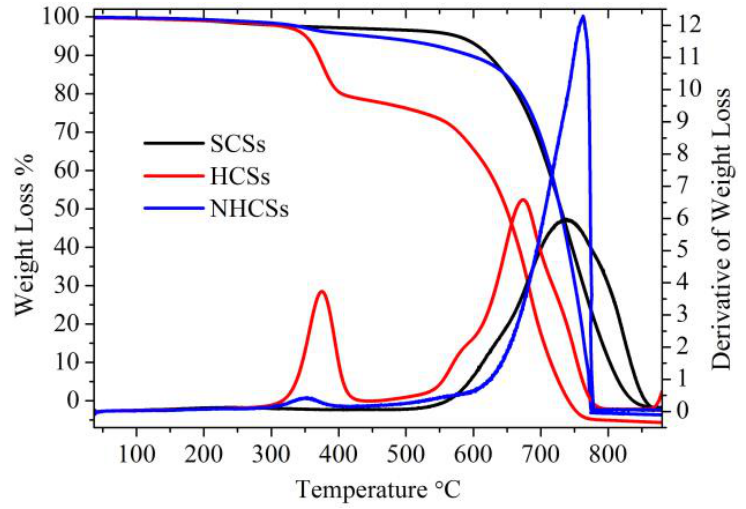
Figure 5. TGA and derivative curves for the SCSs, HCSs, and NHCSs.